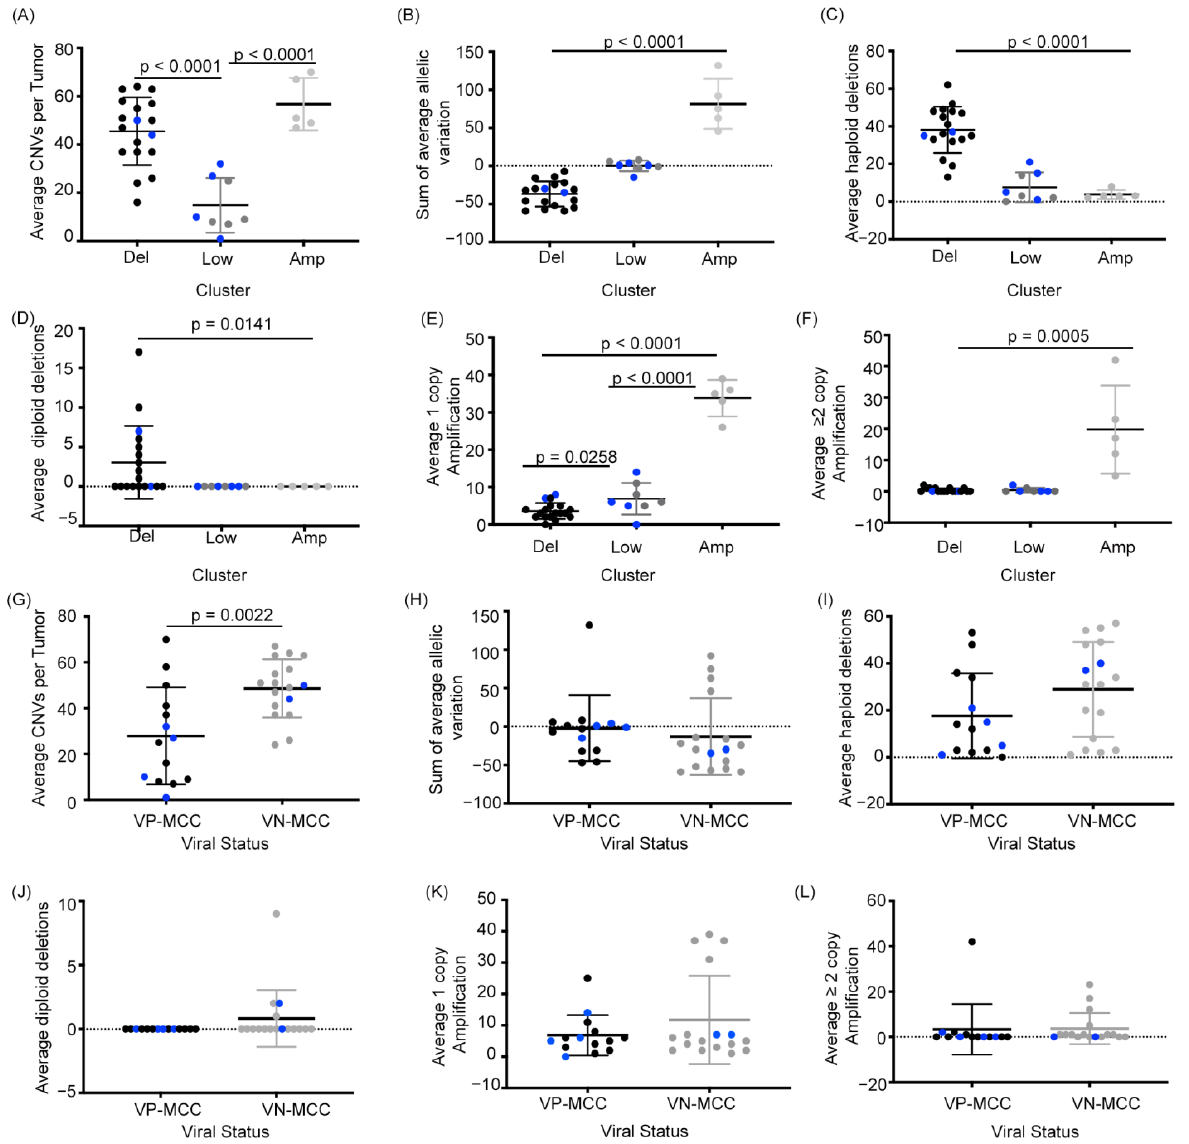
Figure 2. Structural variant clusters show distinct levels and types of CNVs whereas VN-MCC show more structural variation than VP-MCC. Comparison of clusters for the ( A ) average number of CNVs per tumor (one-way ANOVA), ( B ) average sum of allelic variations ( − 1 for each haploid deletion, +1 for each amplification, Kruskal-Wallis test), ( C ) average haploid deletions (Kruskal-Wallis test), ( D ) average diploid deletions (Kruskal-Wallis test), ( E ) average single-copy amplification (one-way ANOVA), and ( F ) average two or greater copy amplifications (Kruskal-Wallis test). Comparison between VP-MCC and VN-MCC for the ( G ) average number of CNVs per tumor (unpaired T-test), ( H ) average sum of allelic variations (Mann-Whitney test), ( I ) average haploid deletions (unpaired T-test), ( J ) average diploid deletions (Mann-Whitney test), ( K ) average single-copy amplification (Mann-Whitney test), and ( L ) average two or greater copy amplifications (Mann-Whitney test). Uncolored dots are primary tumor samples, blue dots indicate metastatic tumor samples.